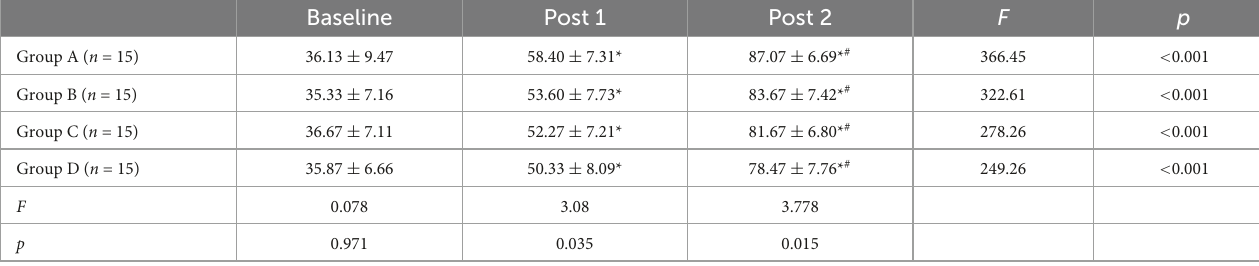
TABLE 4 Modified Barthel Index (MBI) score for all the groups at different time points ( x ± S).